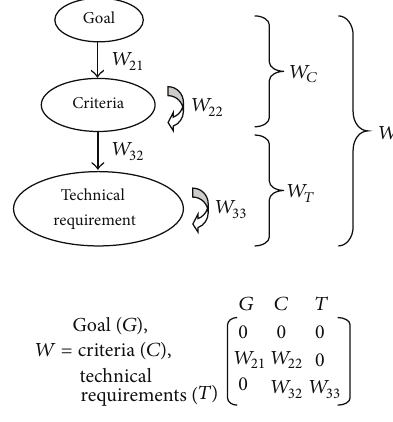
Figure 2: The supermatrix and network.